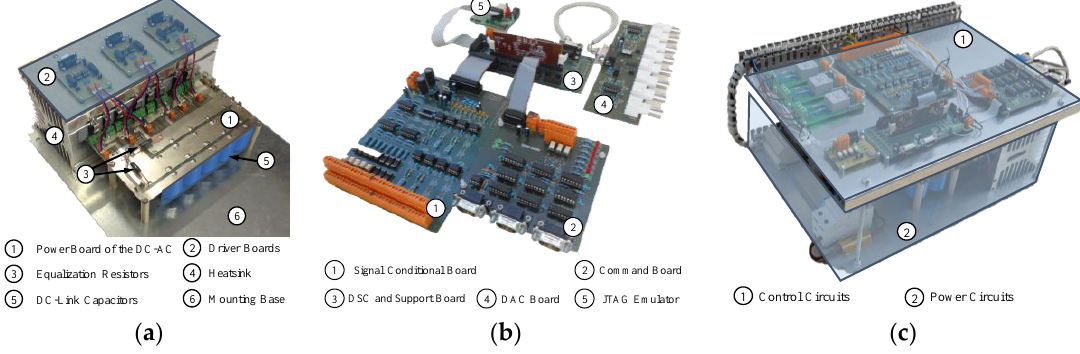
Figure 18. Developed SAPF: ( a ) Power circuits; ( b ) Control circuits; ( c ) Final prototype.